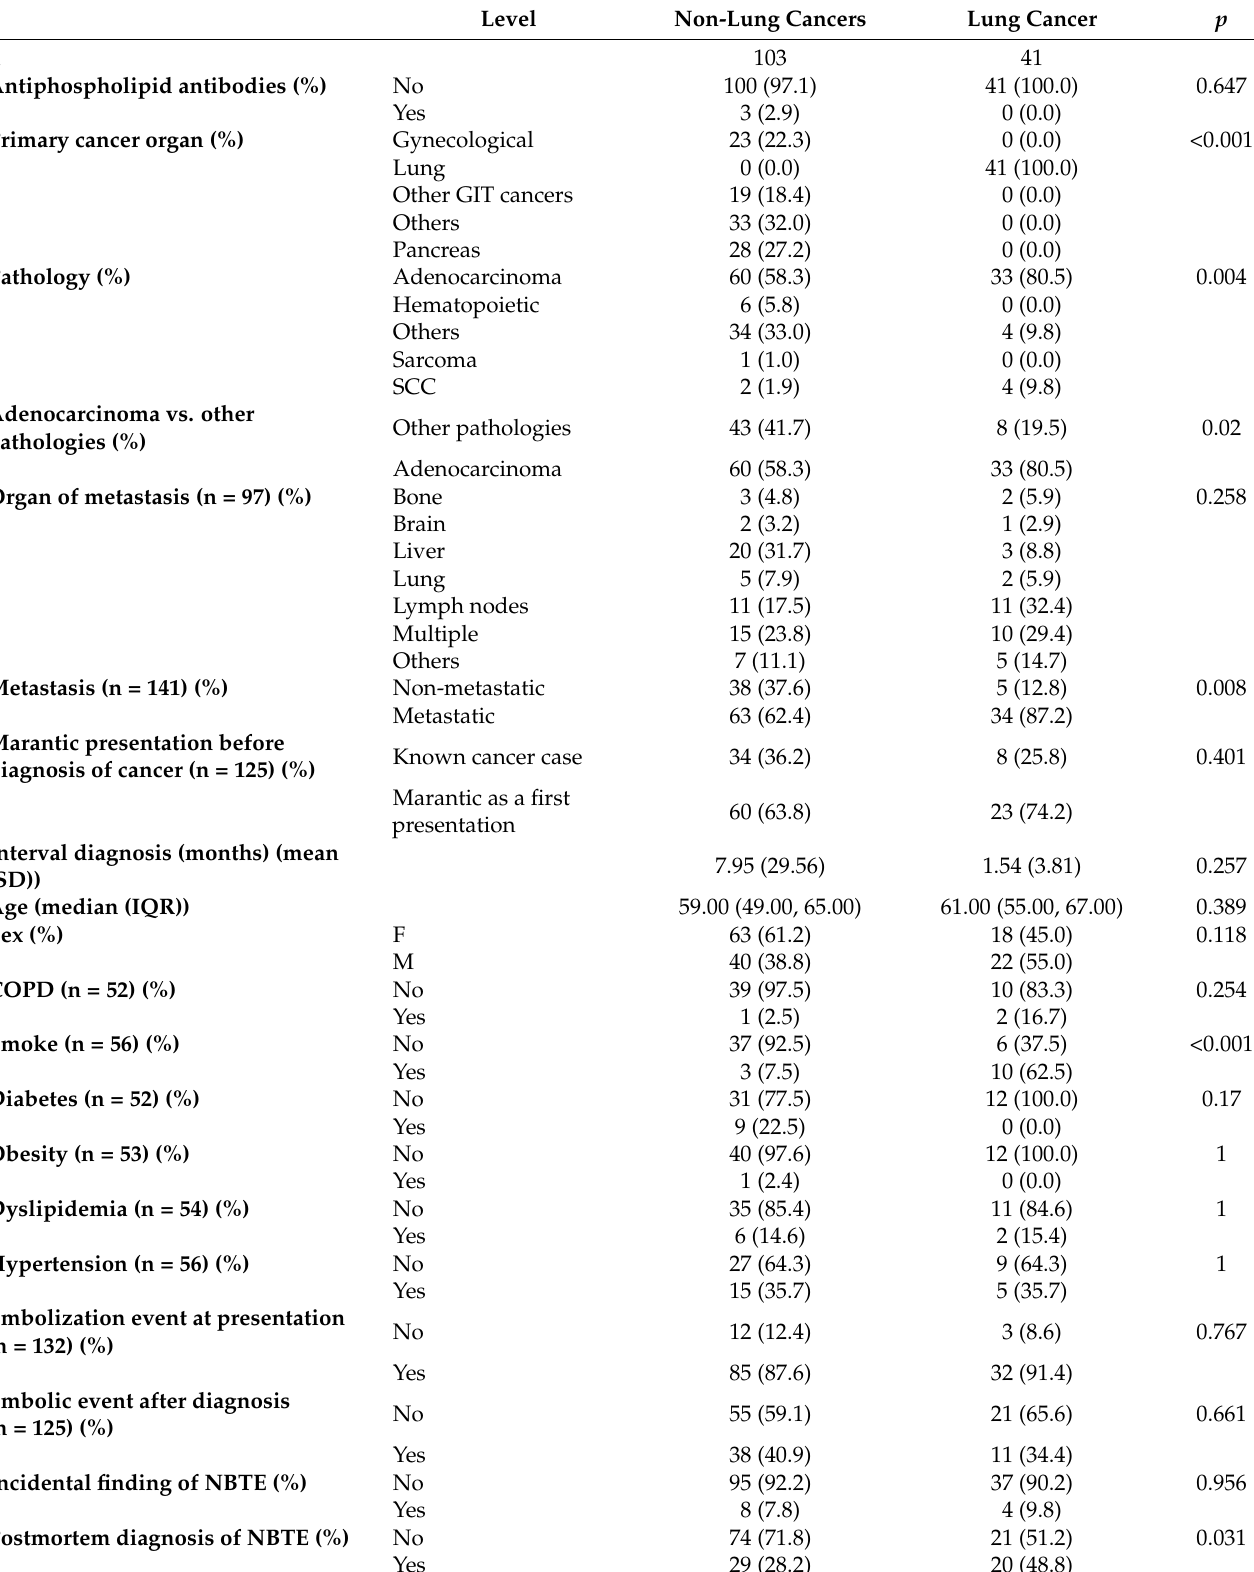
Table 2. Different criteria among lung vs.